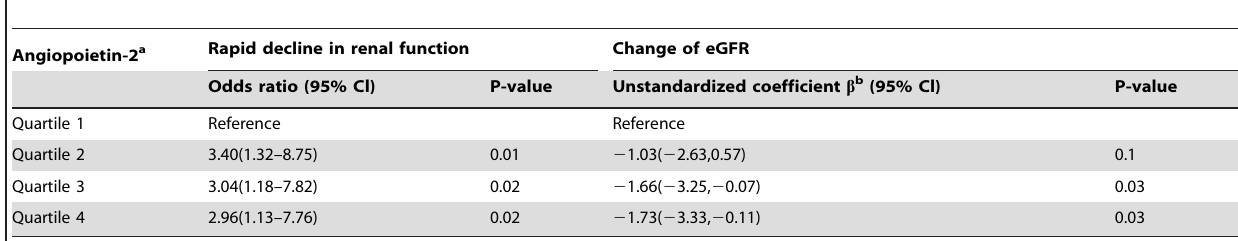
Table 4. The adjusted risks for rapid decline in renal function and change of eGFR according to Angiopoietin-2 quartile.